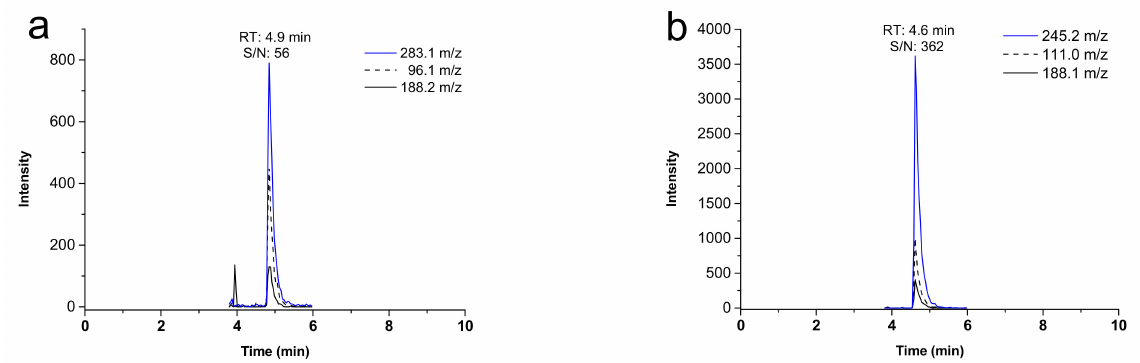
Figure 2. Representative chromatograms of ( a ) transitions m/z 375.1 → 283.1, 375.1 → 188.2, and 375.1 → 96.1 for the LOQ at 10 ng/mL ST-246 (tecovirimat) and ( b ) transitions m/z 337.2 → 245.2, 337.2 → 188.1, and 337.2 → 111.0 of 30 ng/mL IS with the corresponding retention time (RT) and signal-to-noise (S/N)